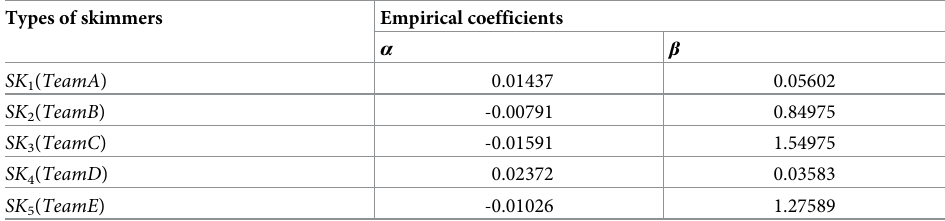
Table 5. Empirical coefficients for the calculations of five ship-mounted skimmers’ oil recovery rates.